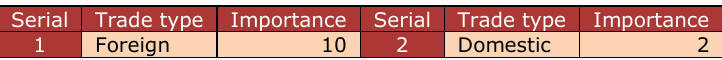
Table 9. Importance of trade